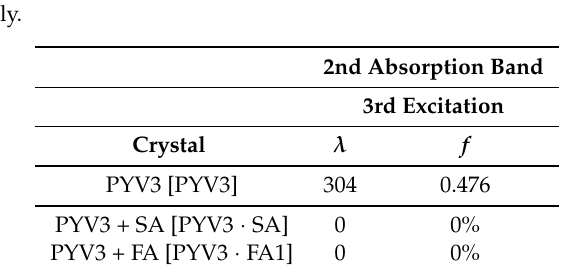
Table A7. RI-CC2/def2-TZVPD wavelengths of excitation, λ in nm, and oscillator strengths, f , for the keto forms of isolated PYV3 (PYV3 [PYV3]) and the heteromers of its co-crystals (PYV3 + XXX [PYV3 · XXX]). For PYV3 [PYV3], the absolute values are given while for the co-crystals, the absolute variations and relative variations are given for the wavelengths and oscillator strengths, respectively.